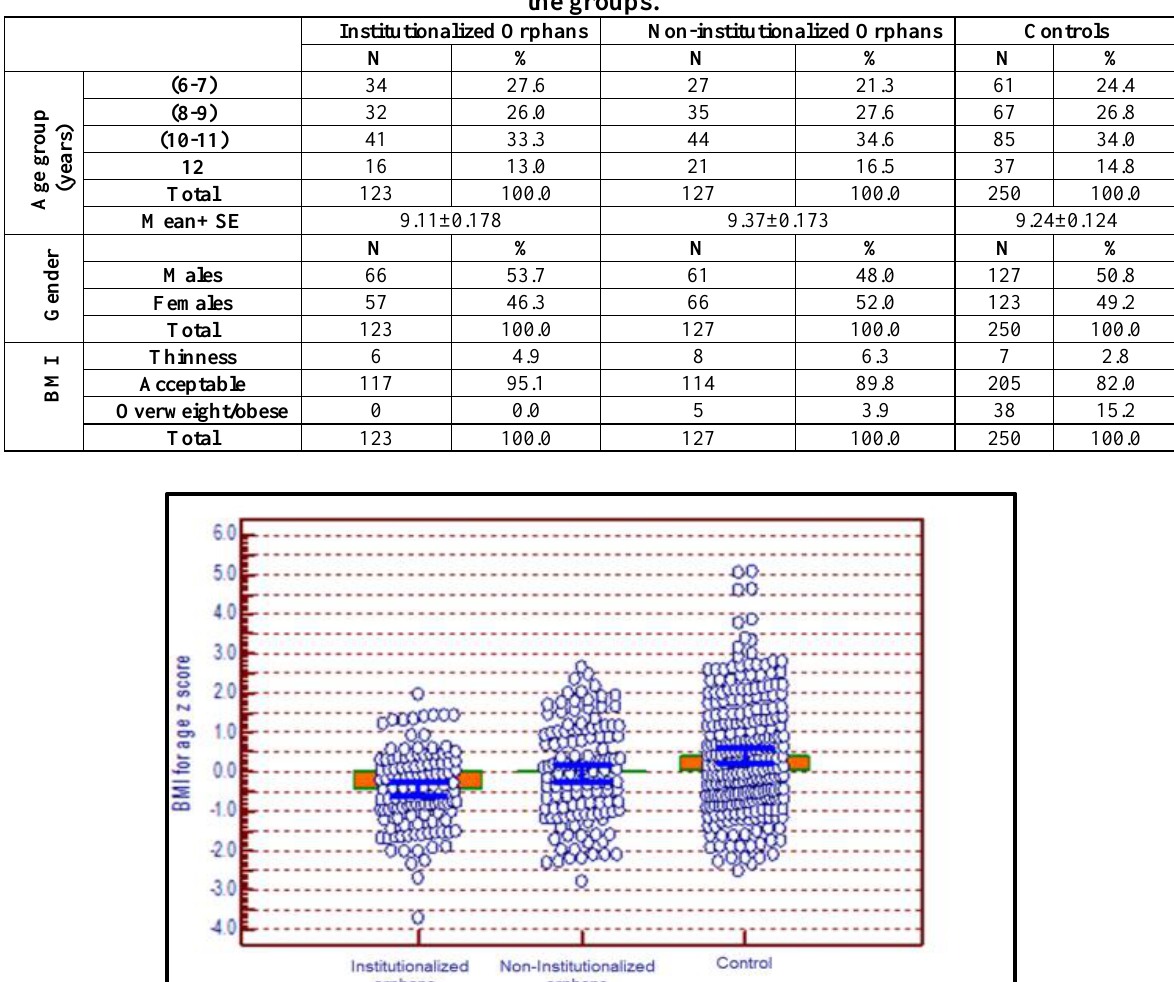
Table 1: Distribution of the sample by age, gender and BMI for age Z score-categories among the groups. Institutionalized Orphans